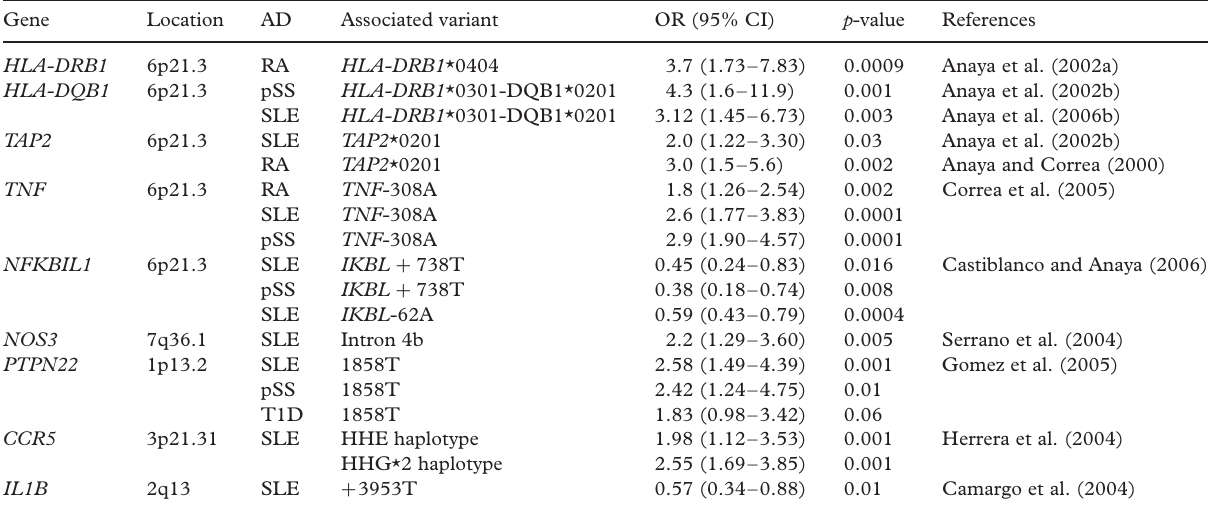
Table II. Genetic polymorphisms associated with ADs in Northwestern